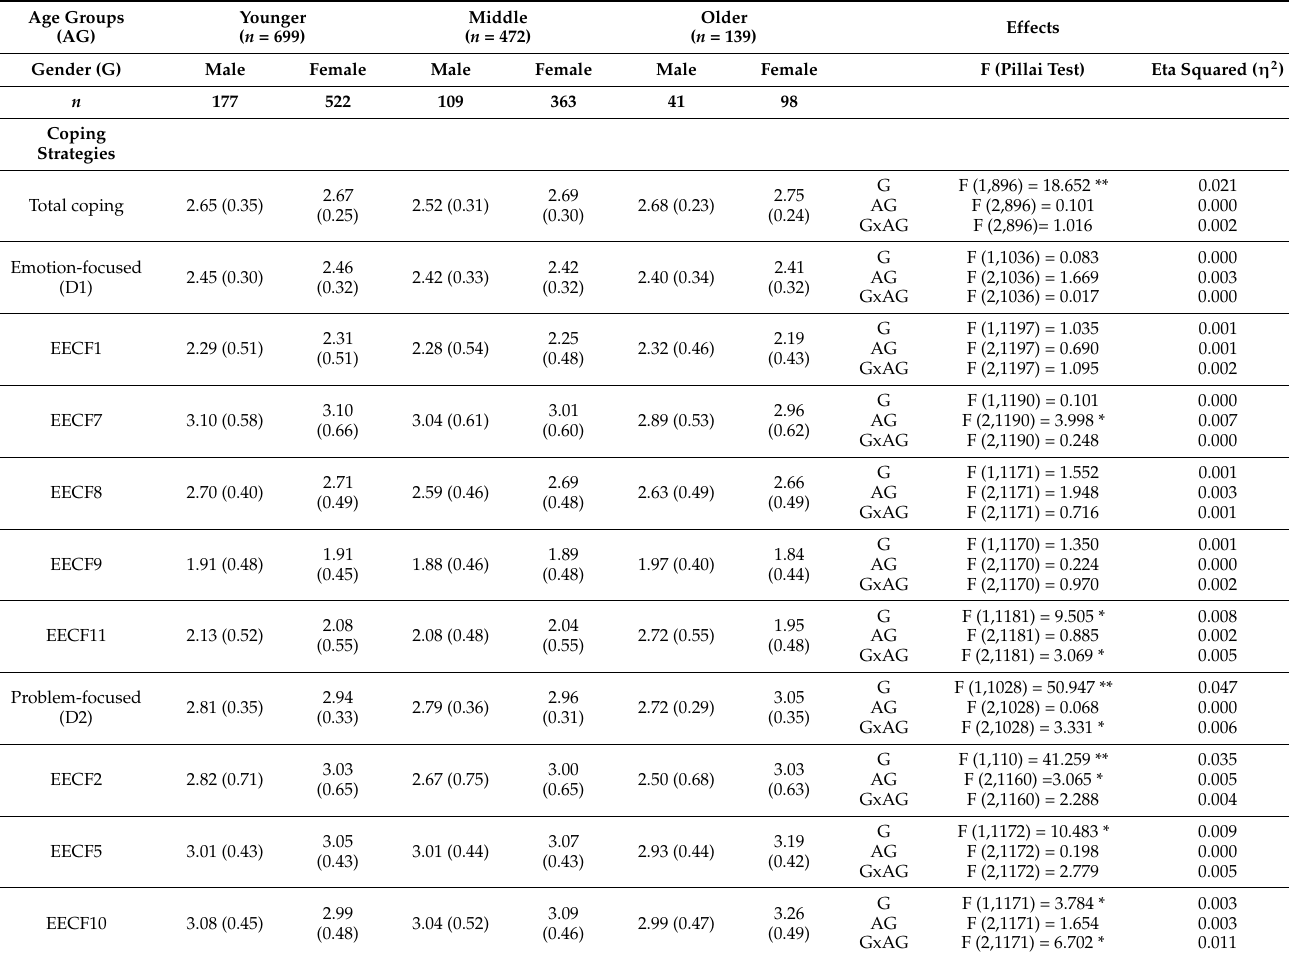
Table 6. Interdependence relations between age groups (AG) and gender (G) as independent variables, in well-being outcomes (dependent